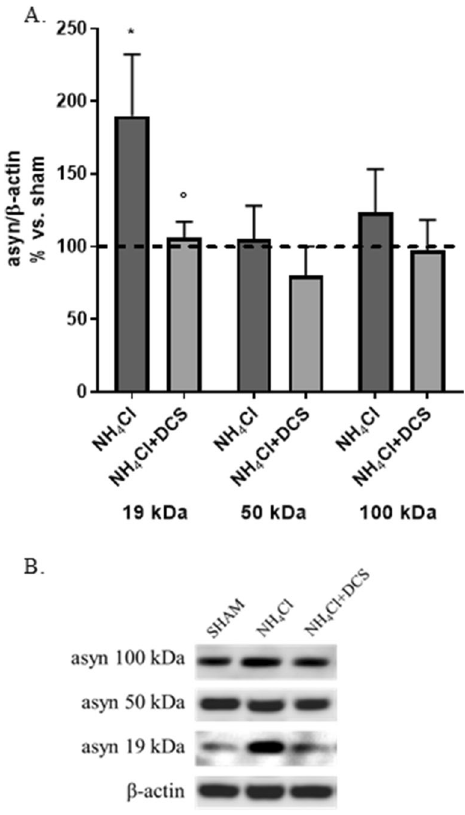
Figure 7. Effects of DCS on protein expression of monomeric (19 kDa) and oligomeric/aggregated (50 and 100 kDa) asyn forms in cells treated with NH 4 Cl (10 mM, 24 h); cells were collected 17 h after DCS (R17); the effect of NH 4 Cl alone on asyn was also shown. DCS counteracted the NH 4 Cl-induced increase of monomeric asyn ( A , B ). ( B ) Representative Western blot image showing immunoreactivity for monomeric (19 kDa) and oligomeric/aggregated (50 and 100 kDa) asyn forms and β-actin, used as internal standard, in cells exposed to sham and cells treated with NH 4 Cl alone or NH 4 Cl and DCS. Blot details and available images are included in Supplementary M&M. (N = 3; *p < 0.05 vs. untreated cells, °p < 0.05 vs. NH 4 Cl-treated